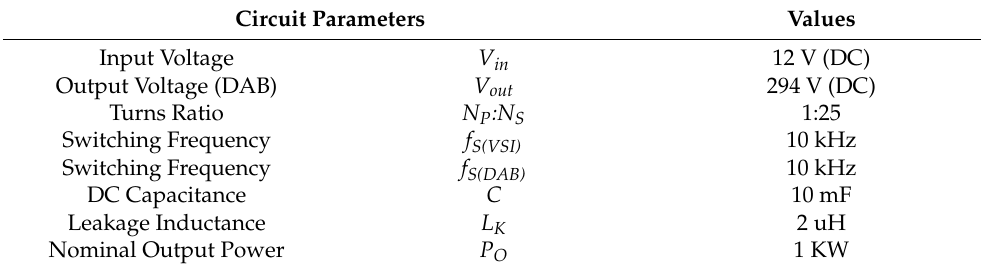
Figure 16. AC output of DAB-based boost inverter. Table 5. Proposed scheme parameters [10].